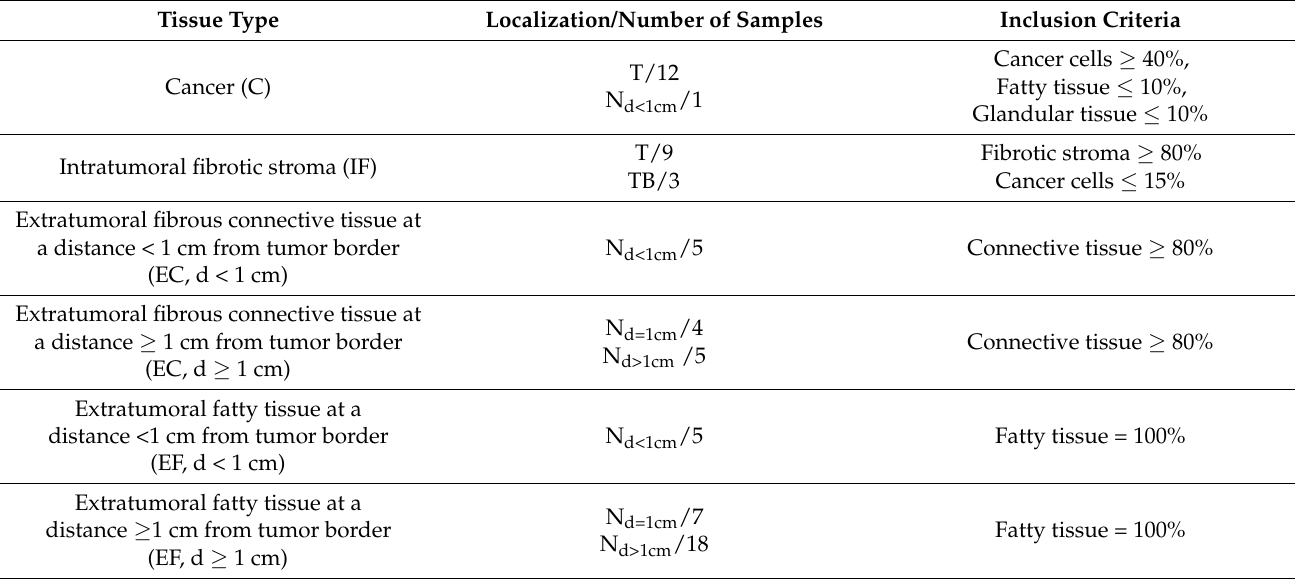
Table 3. The locations of the excisions of the samples and the inclusion criteria for the specimens most representative of a specific tissue type.